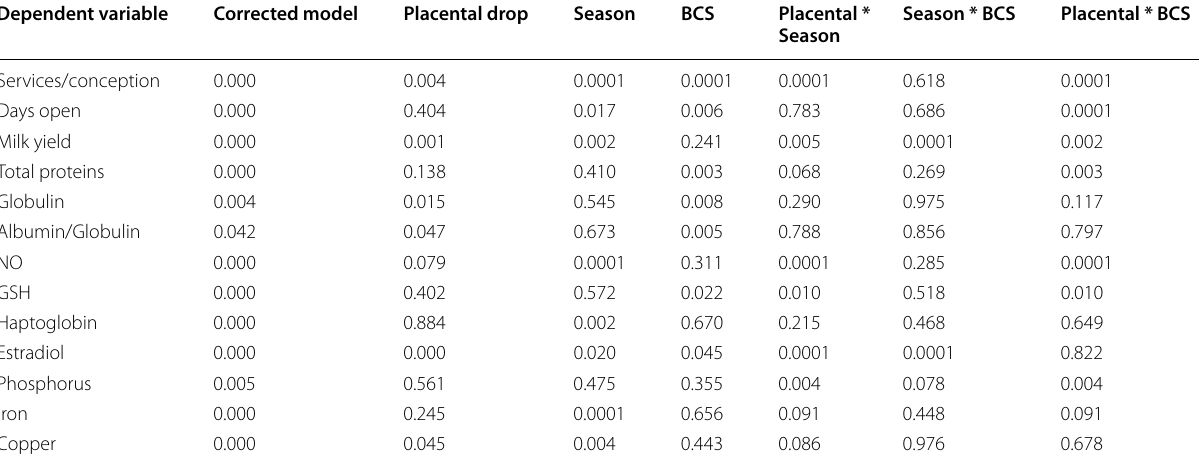
Table 4 The effects of season, BCS, Type of placental drop and their interactions on productive and reproductive